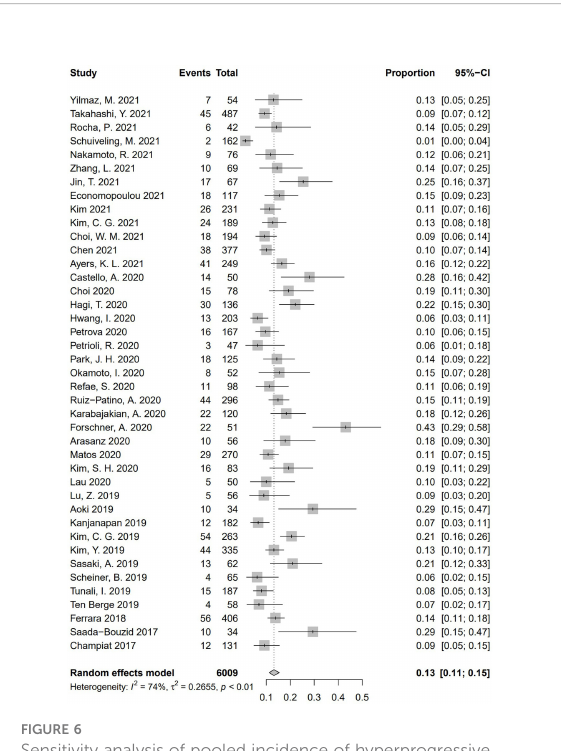
Sensitivity analysis of pooled incidence of hyperprogressive disease in the remaining 40 studies via “ leave-one-out ” method. The “ Study ” column refers to the study omitted in each time of analysis. CI, con fi dence